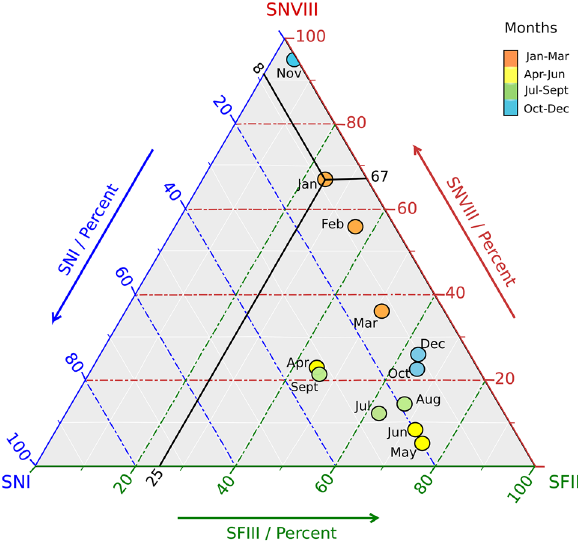
Figure 2. Ternary plot illustrating monthly variation in morphotype composition of Sargassum stranding in Barbados over a 12-month period. Sargassum natans I (SNI), S. natans VIII (SNVIII) and S. fluitans III (SFIII). Black lines indicate the average percent contribution of each morphotype in the January samples (67% SNVIII, 25% SFIII, 8% SNI). Quarterly periods are represented by orange (Jan–Mar), yellow (April–Jun), green (Jul– Sept) and blue (Oct–Dec)